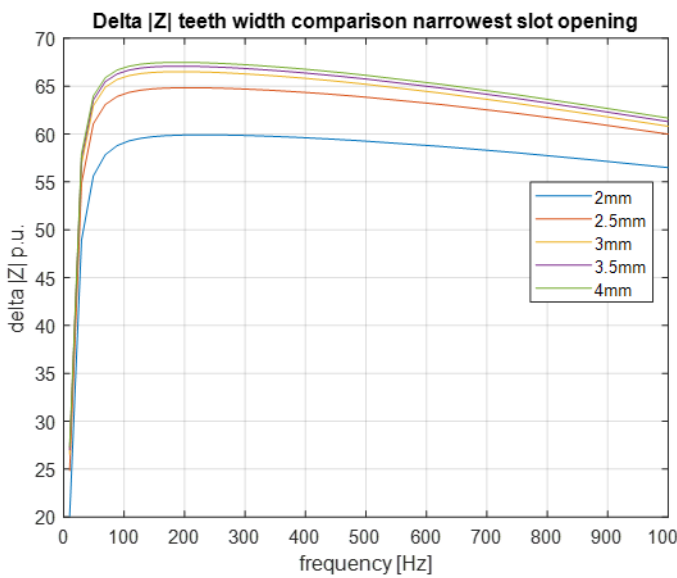
Figure 18. impedance comparison for different teeth width, wso = 1.6 mm.